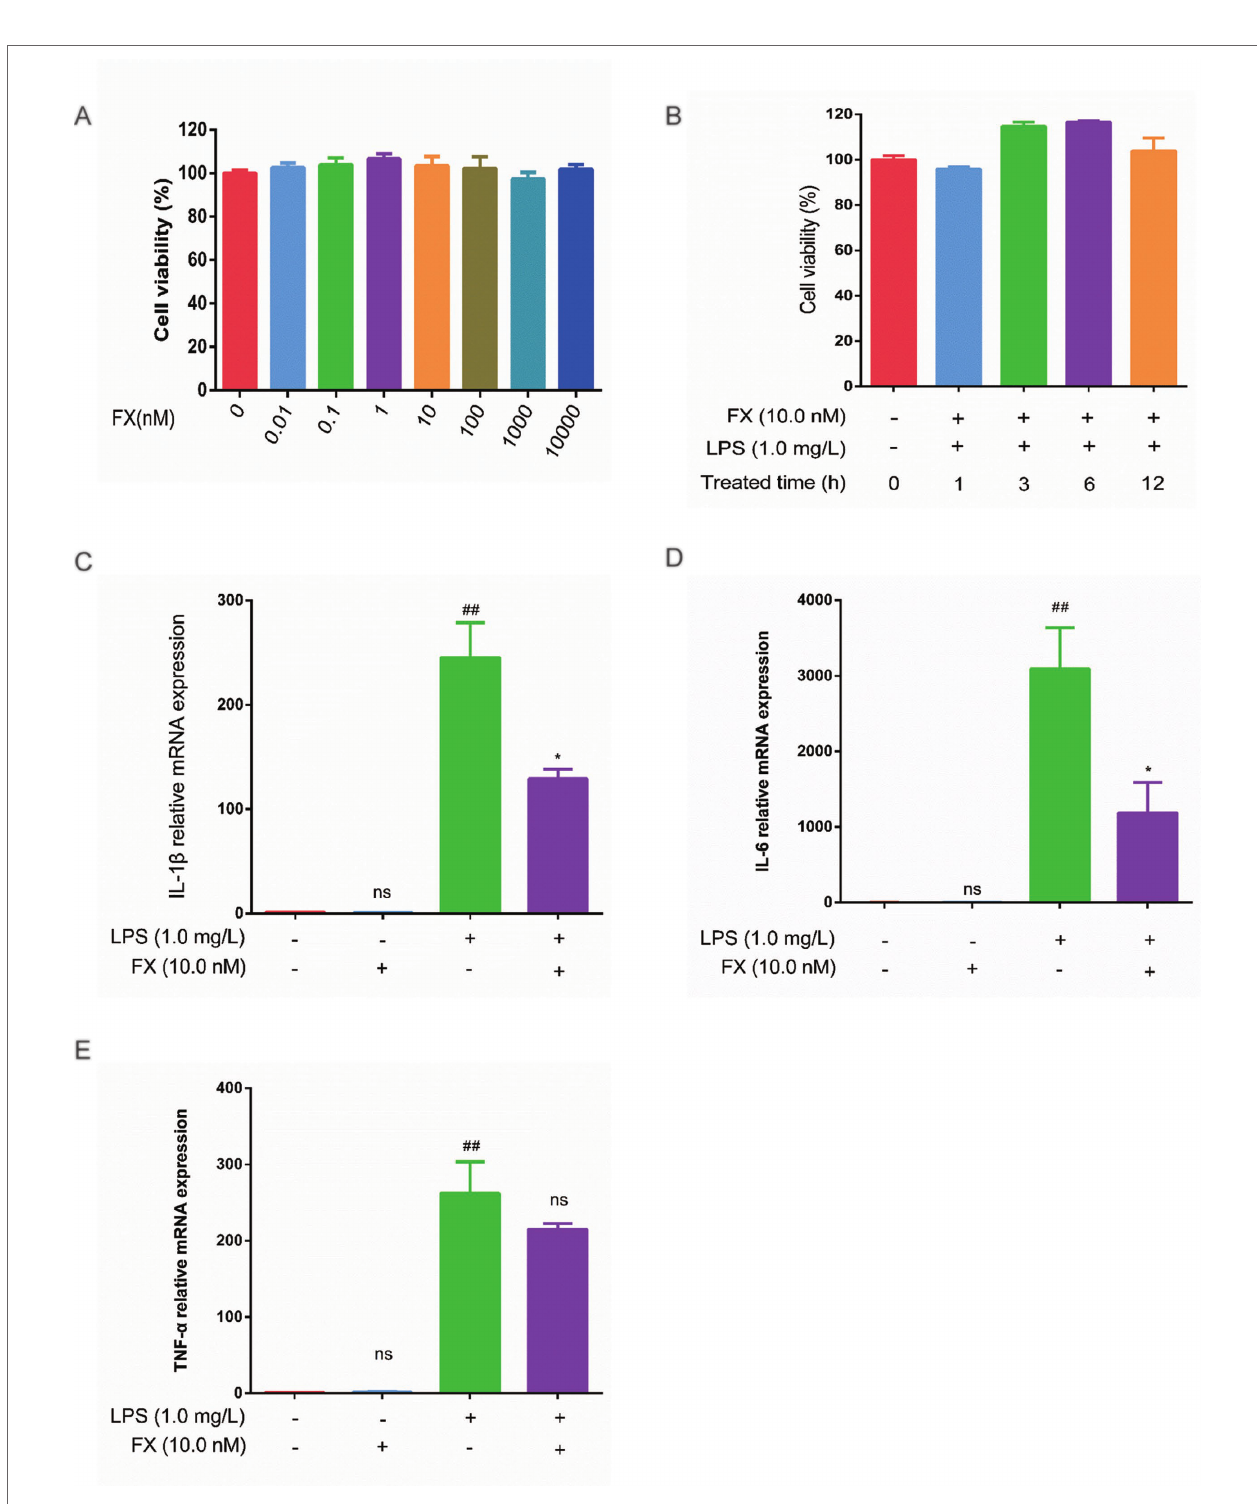
FIGURE 5 | Effects of FX on LPS-treated RAW264.7 cells. (A) Effect of FX treatment (0–10 μM) on cell viability. (B) Effect of FX (10.0 nM) + LPS (1.0 mg/L) co-treatment on cell viability. (C , D , and E) The qPCR was performed to test the changes in cytokine mRNA levels (IL-1 β , IL-6, and TNF- α ) in RAW264.7 cells following FX treatment alone or co-treatment with LPS. The data were analyzed by the one-way ANOVA, followed by Tukey’s post hoc test. (##) p < 0.01, significantly different when compared with that of the control group, ns: not significant. ( ∗ ) p < 0.05, significantly different when compared with that of the LPS group. The data are representative of three independent